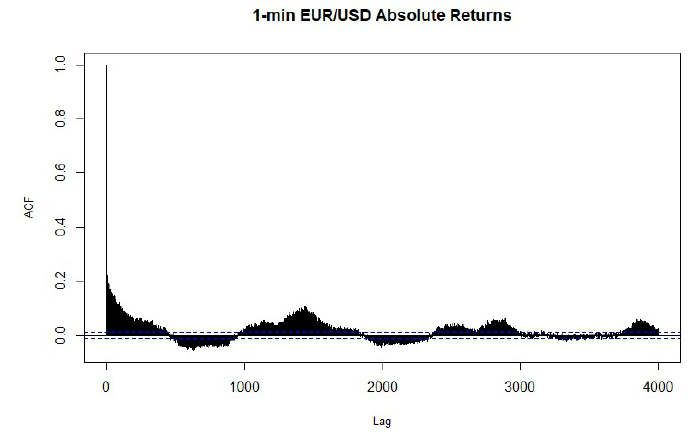
Figure 2. Correlogram of the absolute returns for the 1-min EUR/USD returns. ACF: Auto Correlation Function.